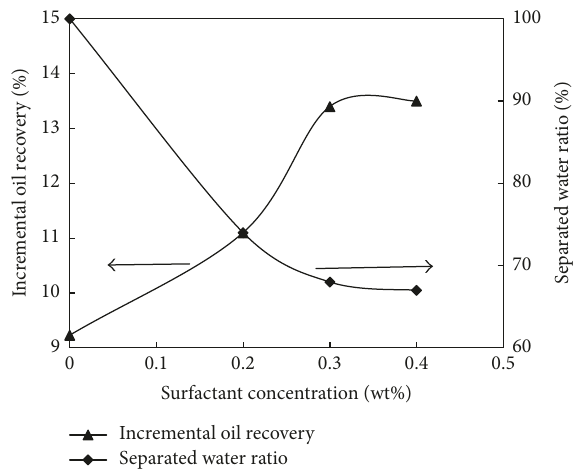
Figure 7: Relationship between enhanced recovery, maximum pressure gradient, reduction of water cut, and viscosity.